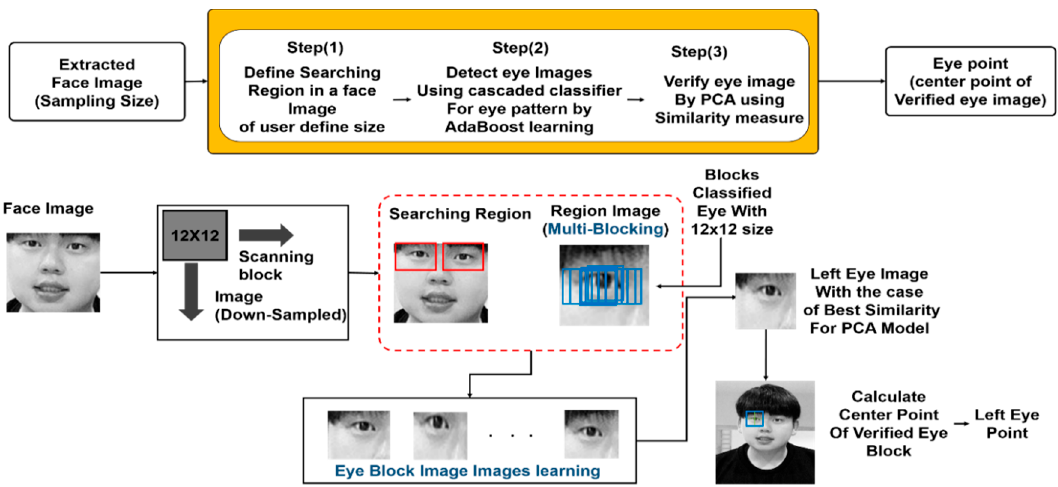
Figure 8. The eye detection process. * The figure included in this image is the author, who agreed to provide the figure.